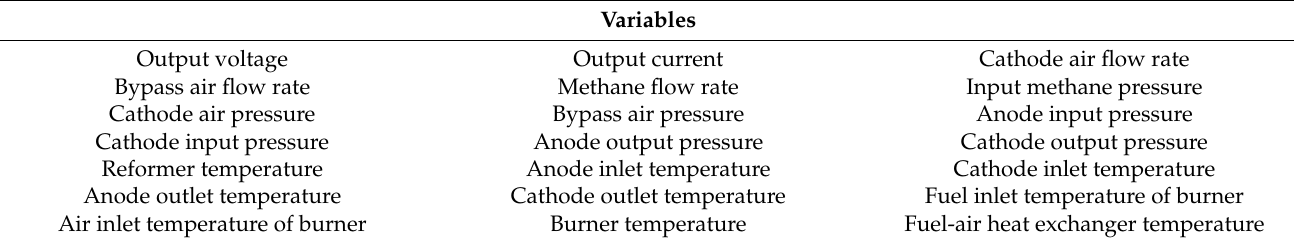
Table 1. The preliminarily selected variables of the SOFC system.